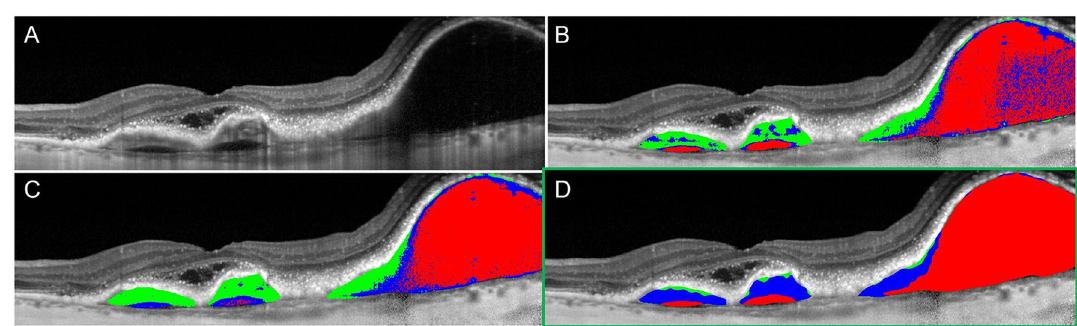
Figure 5. Classified components of a pigment epithelial detachment (PED) using different image techniques on an optical coherence tomography B-scan taken from a patient with neovascular age-related macular degeneration. Classified areas of the PED include serous (red), neovascular (blue), and fibrous (green) components. Original b-scan ( A ). Adaptive thresholding using Otsu’s method ( B ). Unsupervised learning via K-means clustering ( C ). Final pigment epithelial detachment composition index technique using kernel-based image processing techniques ( D